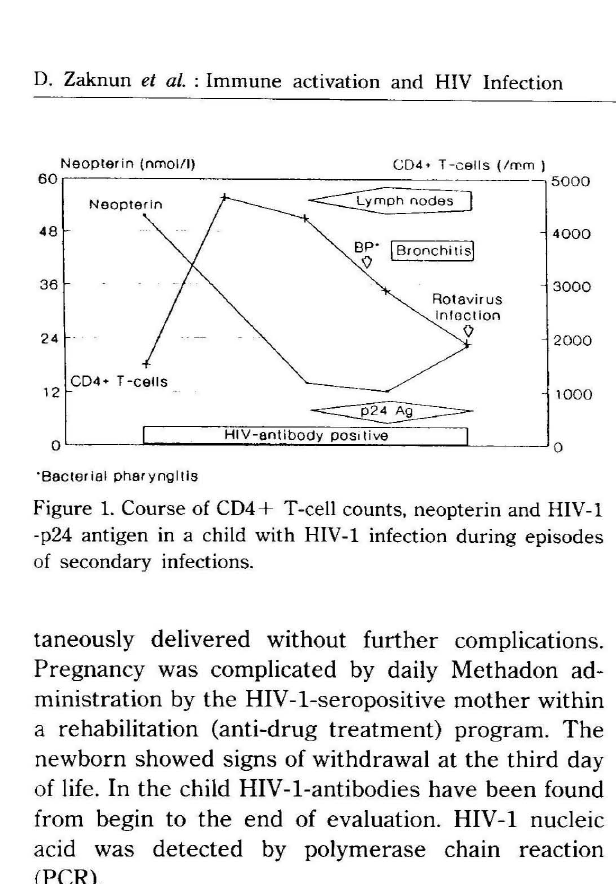
Figure 1. Course of CD4+ T-cell counts, neopterin and HIV-l ·p24 antigen in a child with HIV-1 infection during episodes of secondary